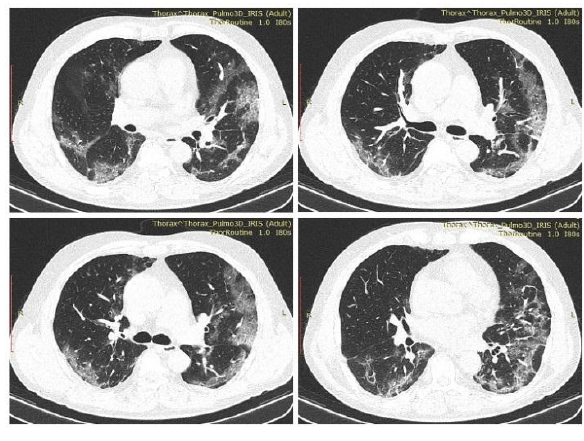
Figure 10 . CT images of patient 2, dynamics – 7 days.